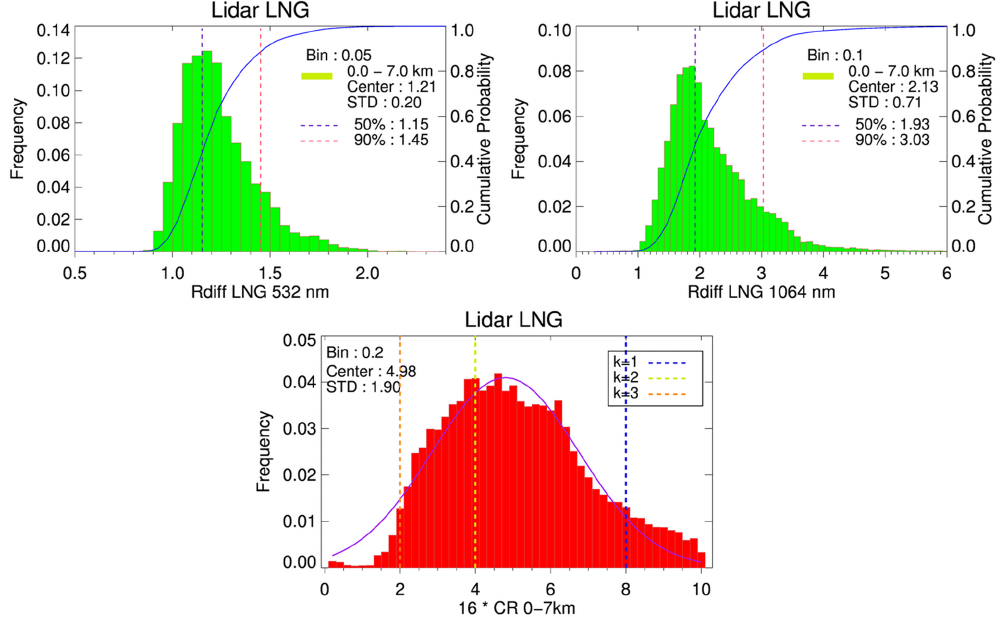
Figure 2. Distribution and cumulative probability (blue) of the 532nm (top left) and 1064nm (top right) backscatter ratios measured by the B- LNG lidar from 30 March to 11 April. Mean, standard deviation, median and 90th percentile are given for each distribution. The distribution of the aerosol colour ratio CR a × 16 (bottom) is compared to the lines for CR a = 0 . 125 ( k = 3), CR a = 0 . 25 ( k = 2) and CR a = 0 . 5 ( k =